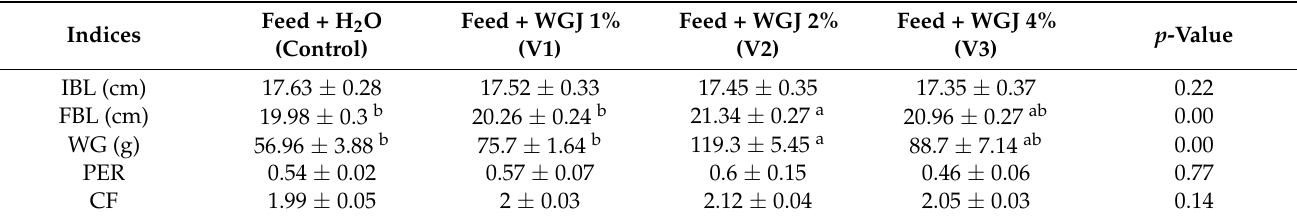
Table 4. Performance of common carp feed four diets with different inclusion levels of wheat grass juice (WGJ).